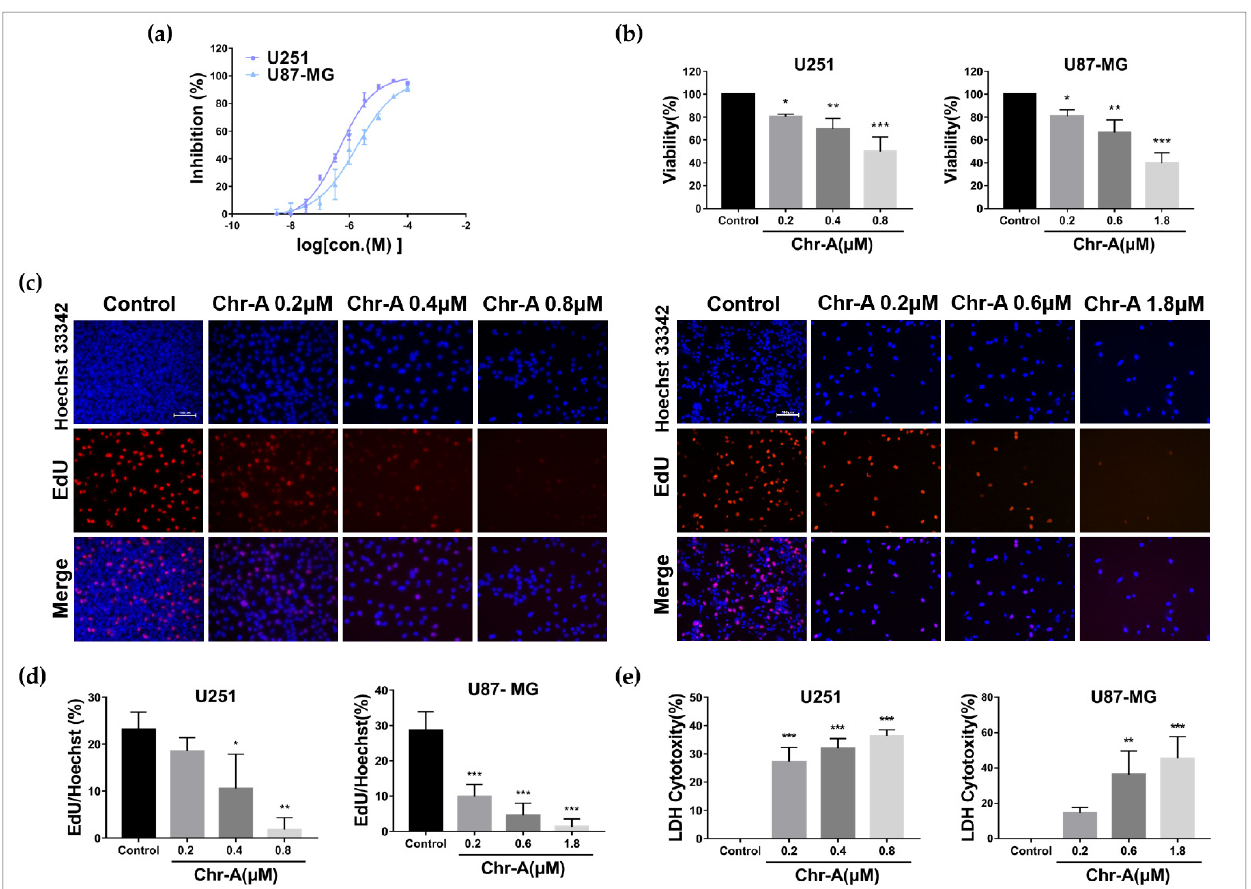
Figure 2. Chr-A causes proliferation inhibition and cytotoxicity rise in the U251 and U87-MG cells. ( a ) The CCK8 assay shows that Chr-A inhibited multiplication of the U251 and U87-MG cells with IC50 at 0.475 μ M and 1.77 μ M, respectively, after treatment for 48 h. ( b ) The CCK8 assay shows that Chr-A inhibited the viability of the U251 and U87-MG cells. ( c , d ) EdU-synthesis detection shows that Chr-A inhibited DNA synthesis in the U251 and U87-MG cells. Red fluorescence represents EdU positive cells, blue fluorescence represents Hoechest 33342 positive cells. Scale bar = 100 μ m. ( e ) LDH detection shows that Chr-A increased cytotoxicity of the U251 and U87-MG cells. Data are